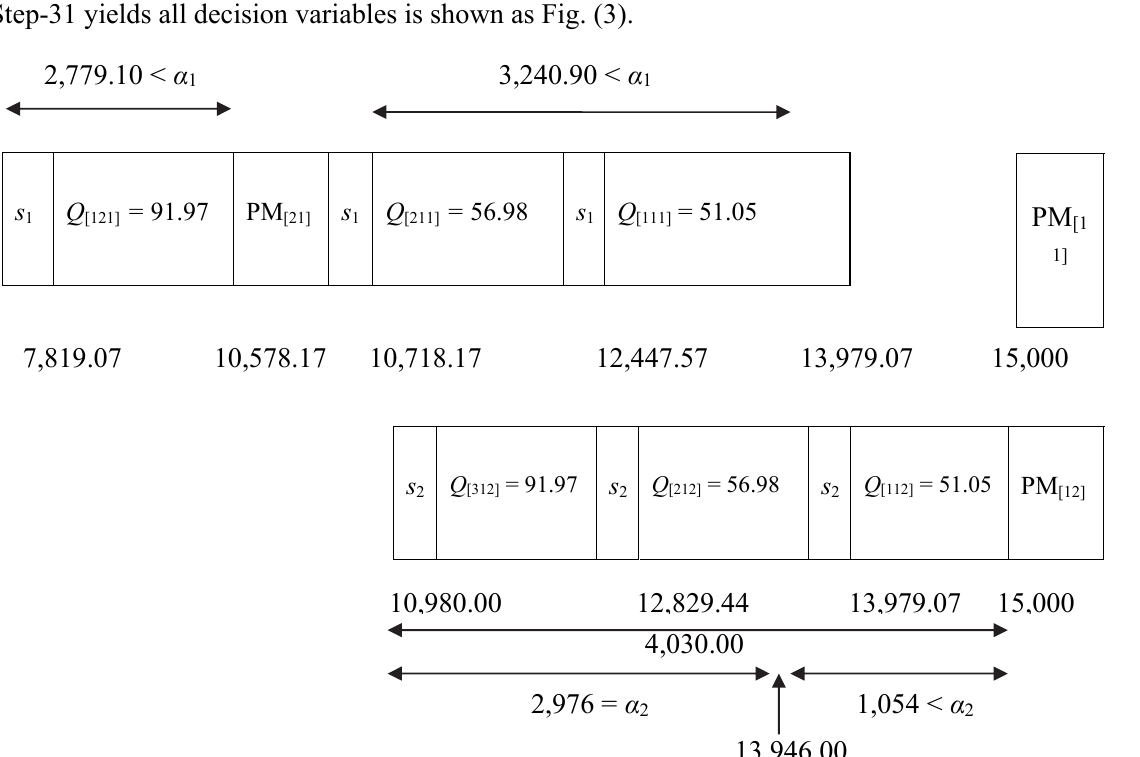
Step-31 yields all decision variables is shown as Fig. (3).